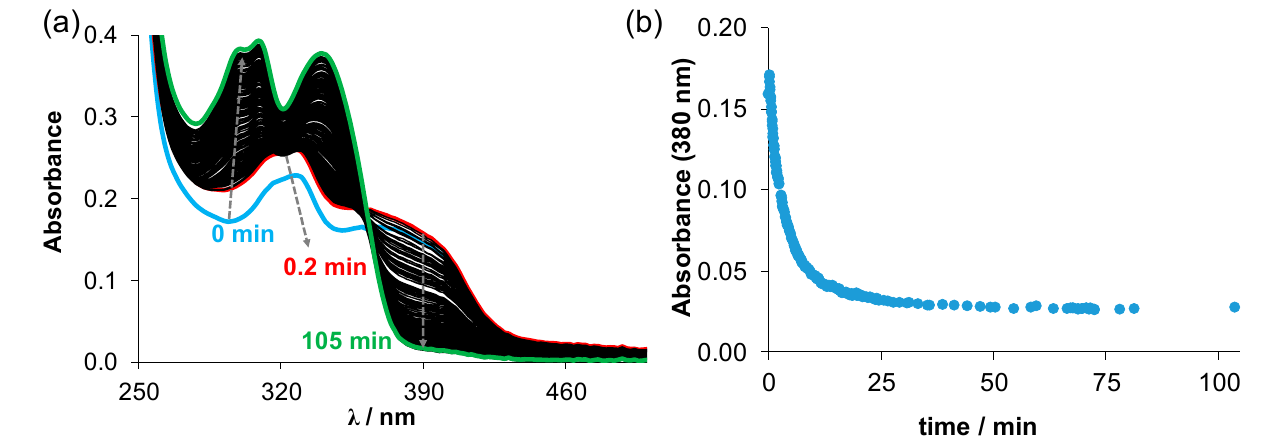
Figure 7. ( a ) Time-dependent changes of the UV–vis spectra recorded for the Cu-Me-estradiol-TSC complex (25 μ M) in the presence of 50 equiv. GSH (1.25 mM) at pH 7.4 (10 mM HEPES) in 30% ( v/v ) DMSO/H 2 O under anaerobic conditions. ( b ) Absorbance values at 380 nm plotted against the time. ( T = 25 °C; I = 0.1 M (KCl)).